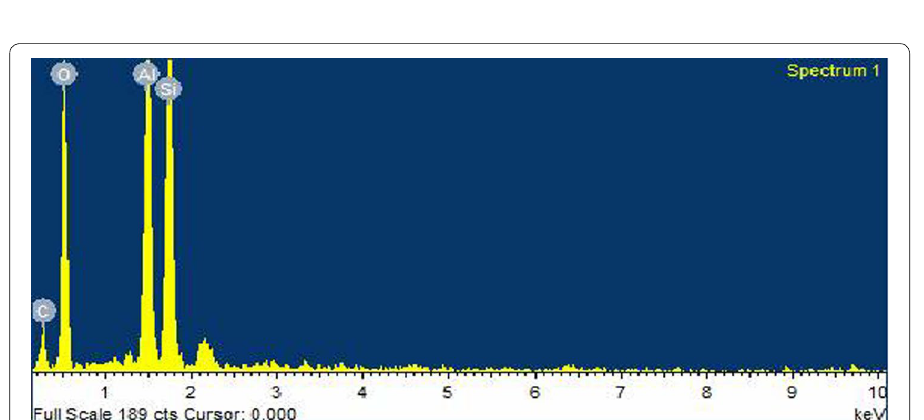
Fig. 12 Energy dispersive X-ray (EDX) graphs of Borabanda